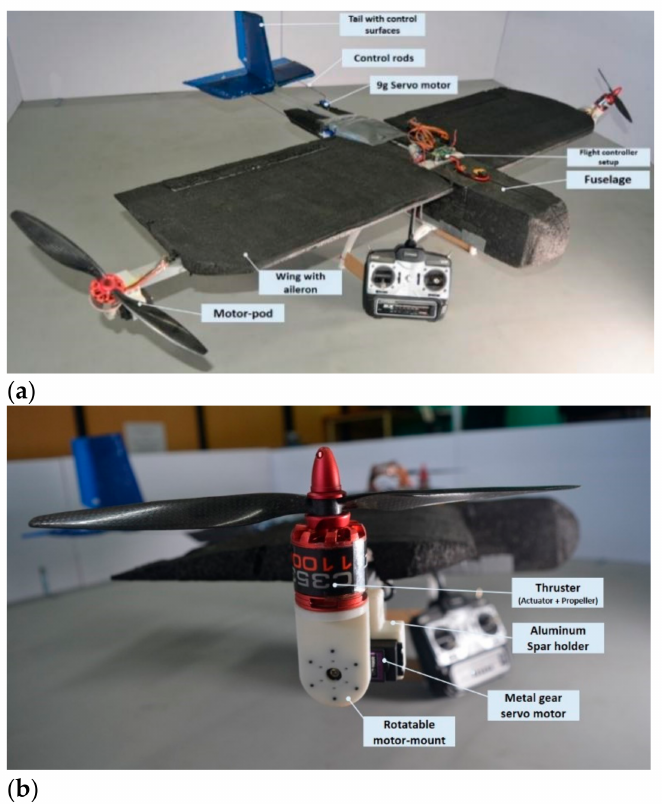
Figure 20. ( a ) Fabricated prototype of Hybrid VTOL tilt-rotor laying down the individual components and ( b ) the fabricated prototype of motor